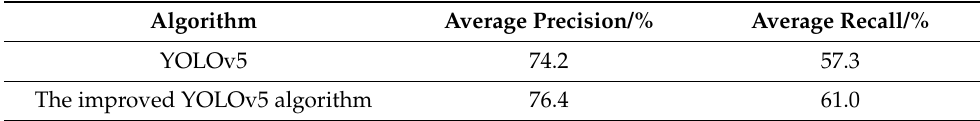
Table 7. Recognition results of improved YOLOv5 Algorithms with